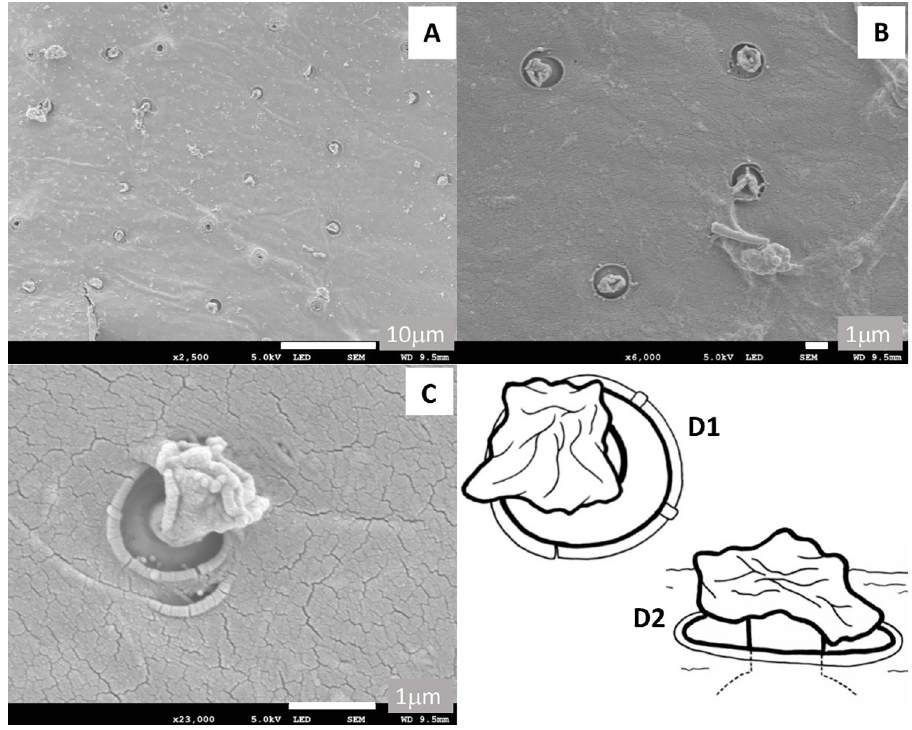
Fig 6. SEM of the interior surface M . migonei showing the observable cuticular elements of the secretory apparatus. A) Distribution of the secretory structures on the inner surface of the abdominal cuticle on tergite III, B) secretory apparatus set within a deep pocket embedded in the abdominal cuticle on tergite IV, C) close-up of a secretory unit showing the manifold embedded within the abdominal cuticle observed at the bottom of the pocket on tergite III. D1) Drawing of the M . migonei secretory apparatus from above (top left) showing the reservoir positioned over the hole in the abdominal cuticle and then D2) a side-on view showing the reservoir connected via cuticular to the top of the manifold sitting within the hole in the